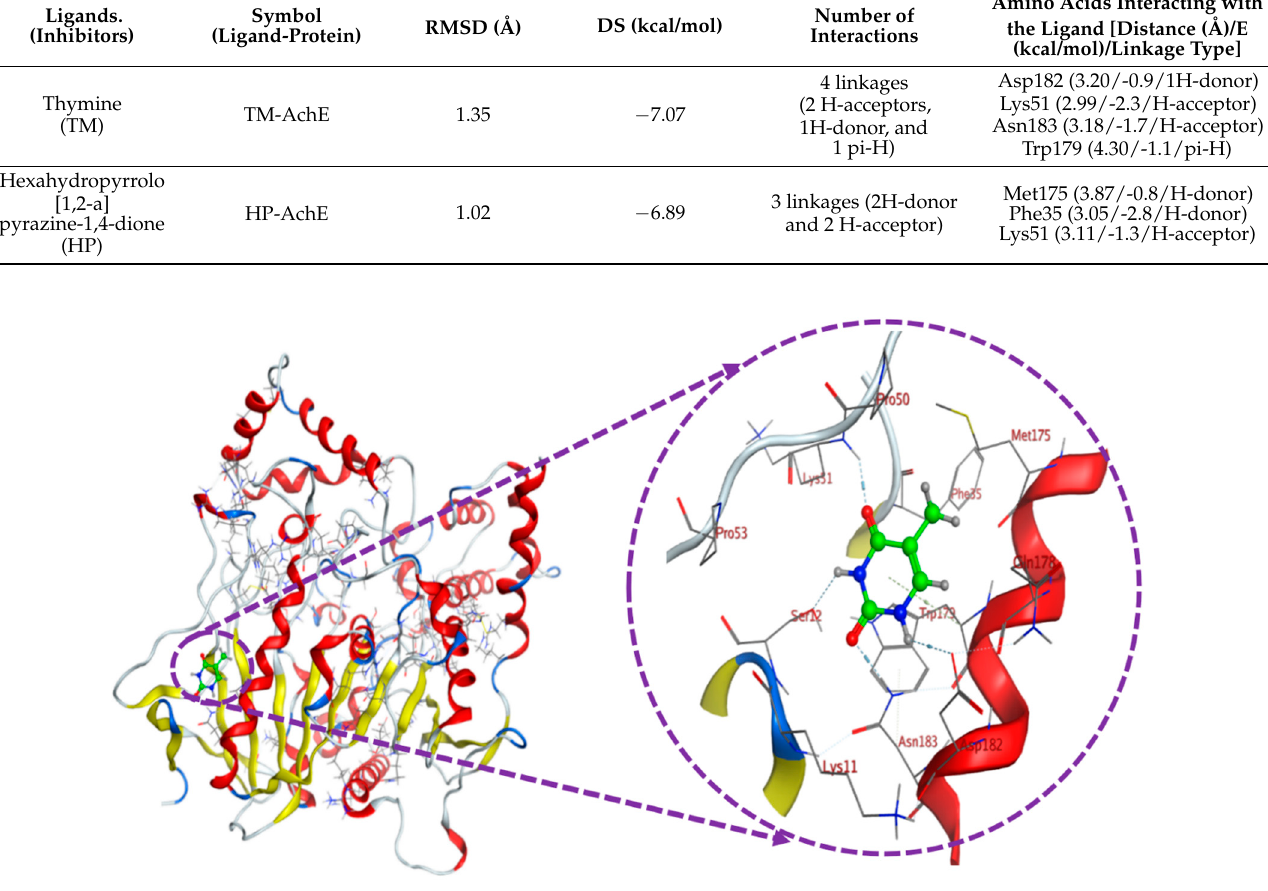
Figure 4. Interaction of thymine with enzyme acetylcholinesterase-targeting antinematode effects at the active site .